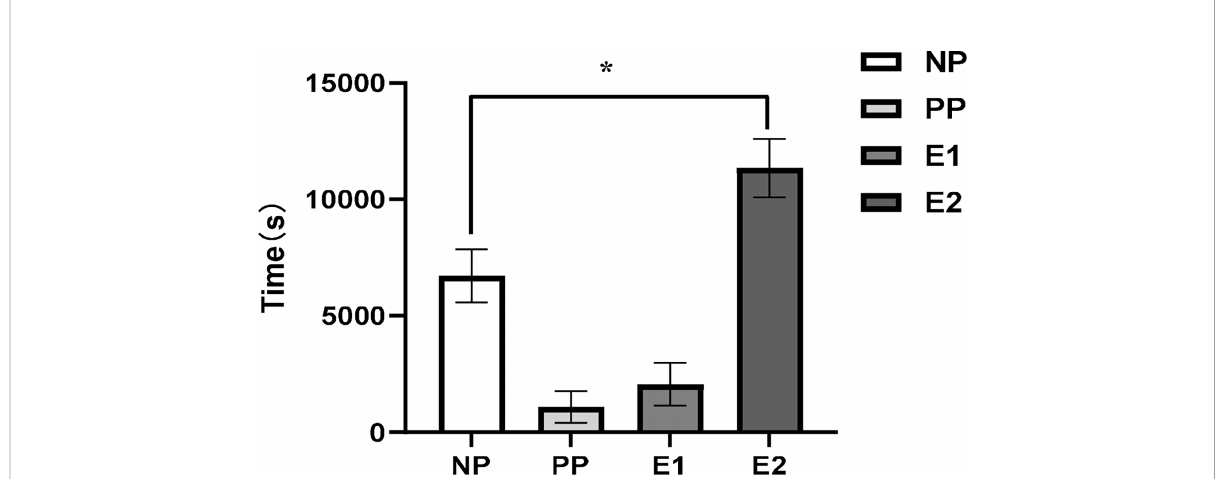
FIGURE 3 Mean ( ± SE, n = 5) duration of each feeding waveforms of adult Diaphorina citri feeding on Nicotiana tabacum leaves (ANOVA, LSD, * P < 0.05). (NP, non-probing phase; PP, pathway phase; E1, phloem salivation; E2, phloem ingestion).